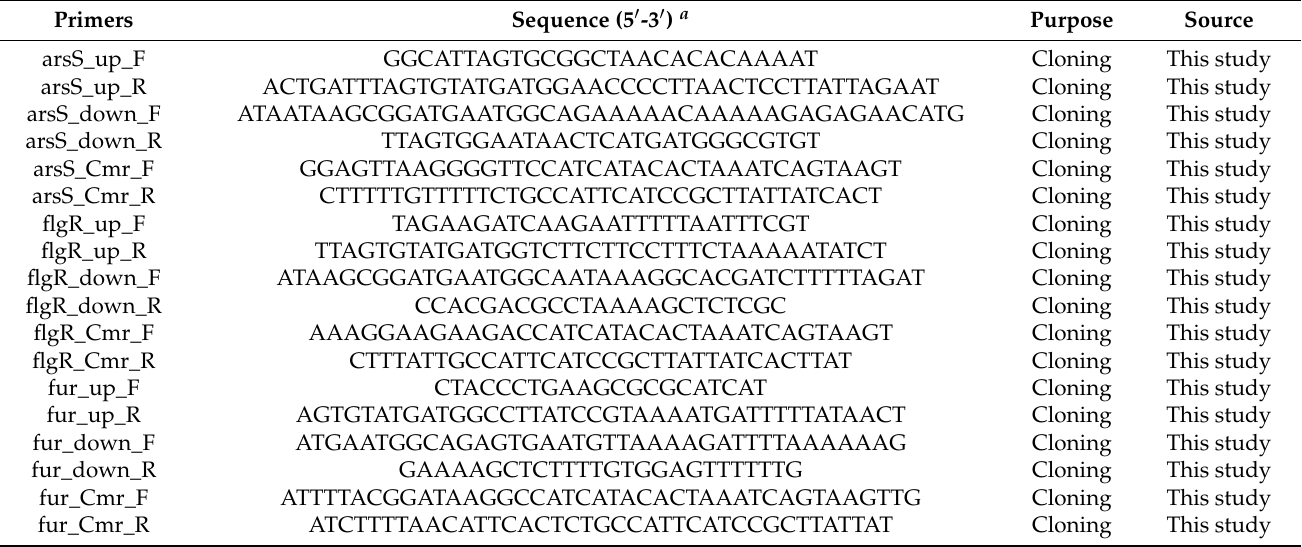
Table 2. Primers used in this